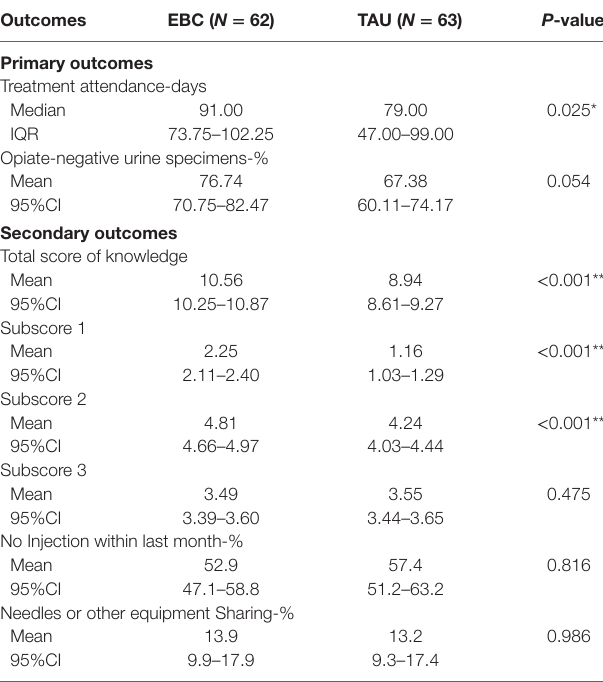
TaBlE 3 | Primary and secondary outcomes in educational and behavioral counseling (EBC) and treatment as usual (TAU)